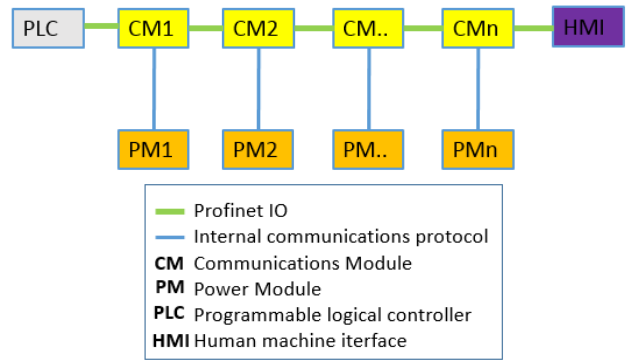
Fig. 9. Line structure of Profinet IO